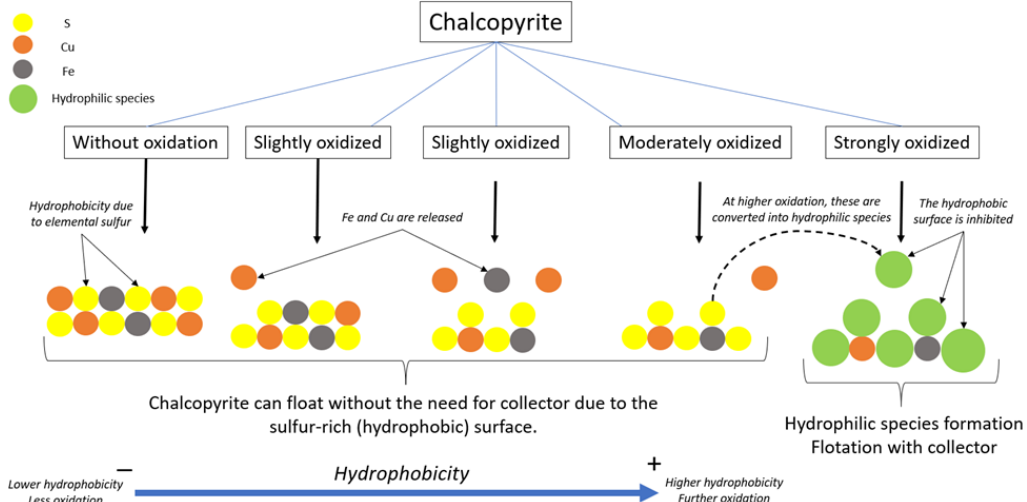
Figure 2. Sulfide oxidation mechanisms (adapted from Aghazadeh et al. [7]).